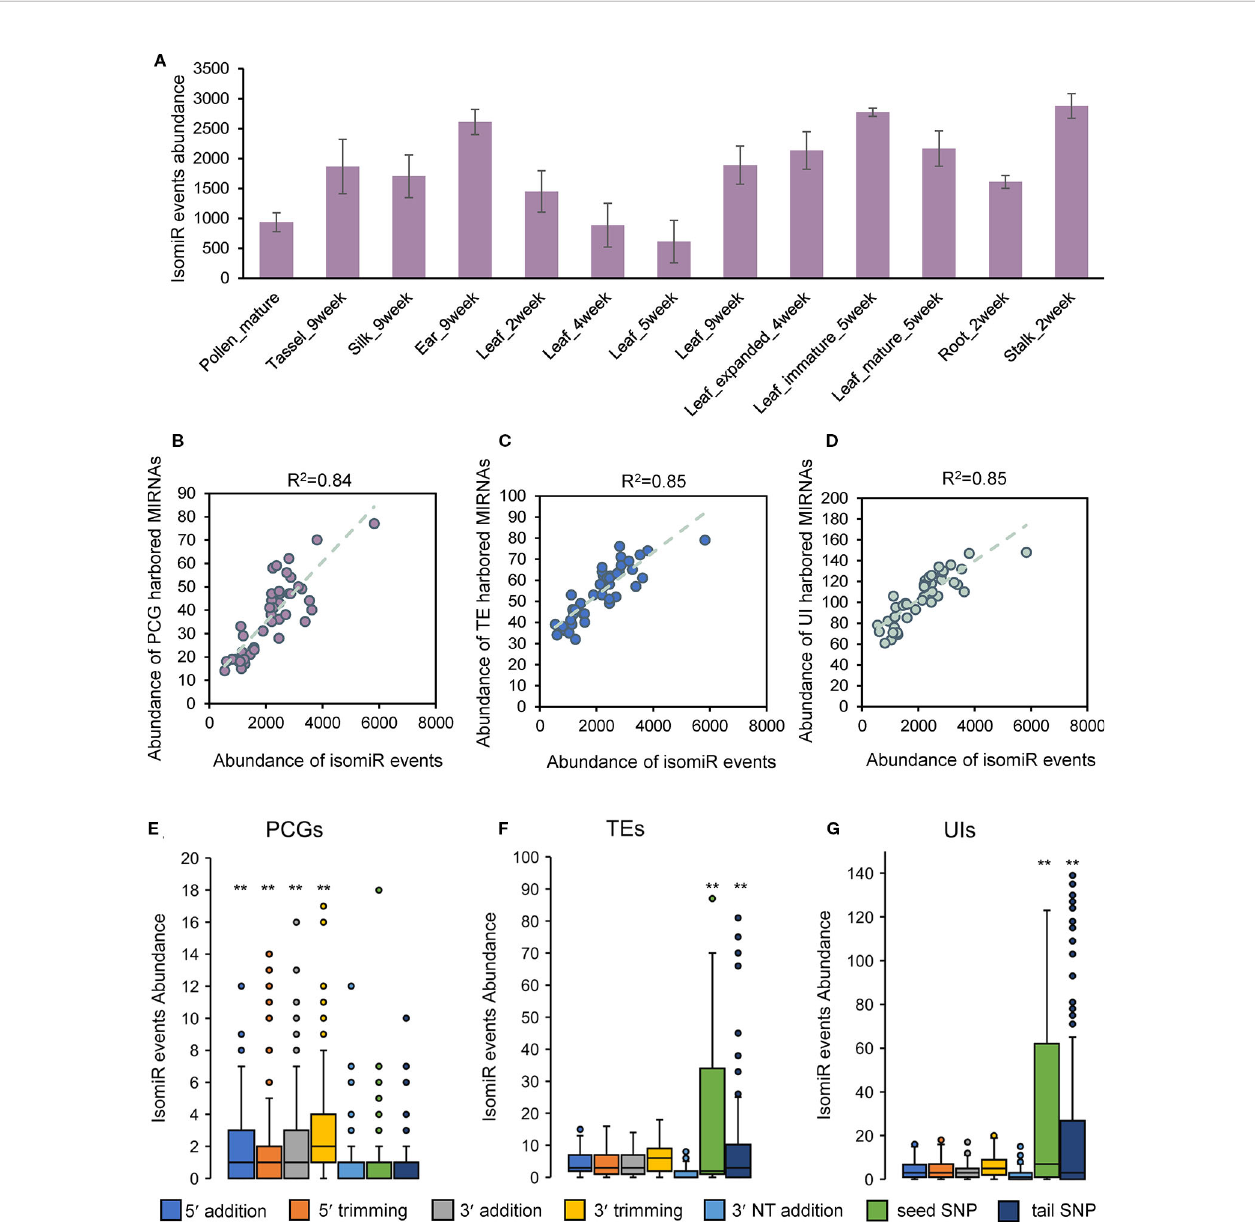
FIGURE 4 | Dynamic patterns of isomiR events in terms of tissue types and genomic environments. (A) Abundance of isomiRs varied widely among individual tissues. (B) Correlation between the abundance of isomiR events and PCG-harbored miRNA genes in all tissue samples. (C) Correlation between the abundance of isomiR events and TE-harbored miRNA genes in all tissue samples. (D) Correlation between the abundance of isomiR events and UI-harbored miRNA genes in all tissue samples. (E) Comparisons of isomiR abundance among seven isomiR types in PCG-harbored miRNA genes. (F) Comparisons of isomiR abundance among seven isomiR types in TE-harbored miRNA genes. (G) Comparisons of isomiR abundance among seven isomiR types in UI-harbored miRNA genes. Statistically signi fi cant differences in (E, F and G) were determined using Student's t -test and **indicated P-value <